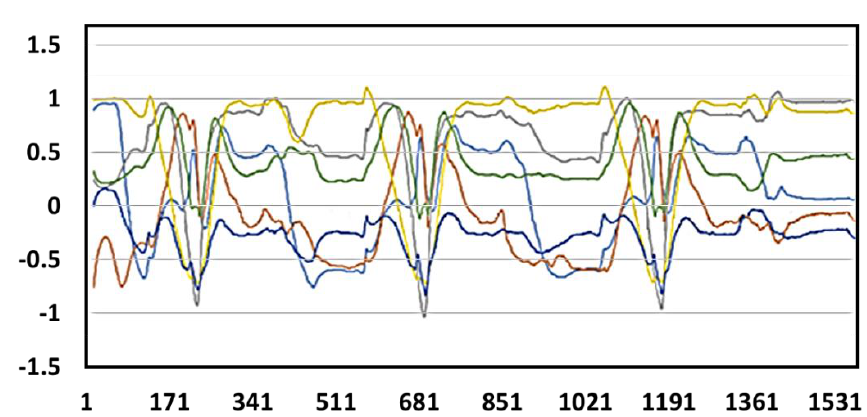
Figure 15. Continuous action signal in multiple throws using right hand .